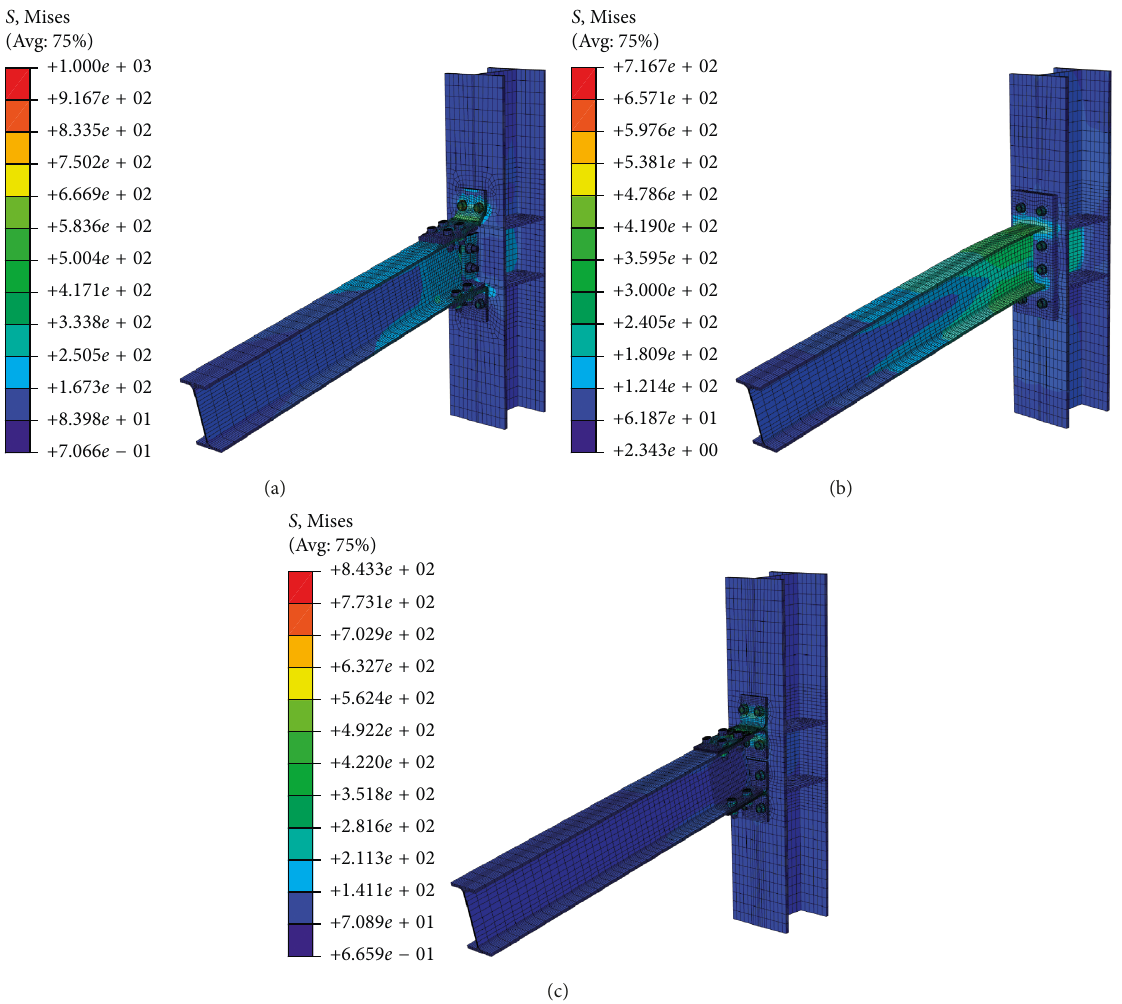
Figure 17: Stress nephogram of the joints. (a) J-1. (b) J-2. (c)